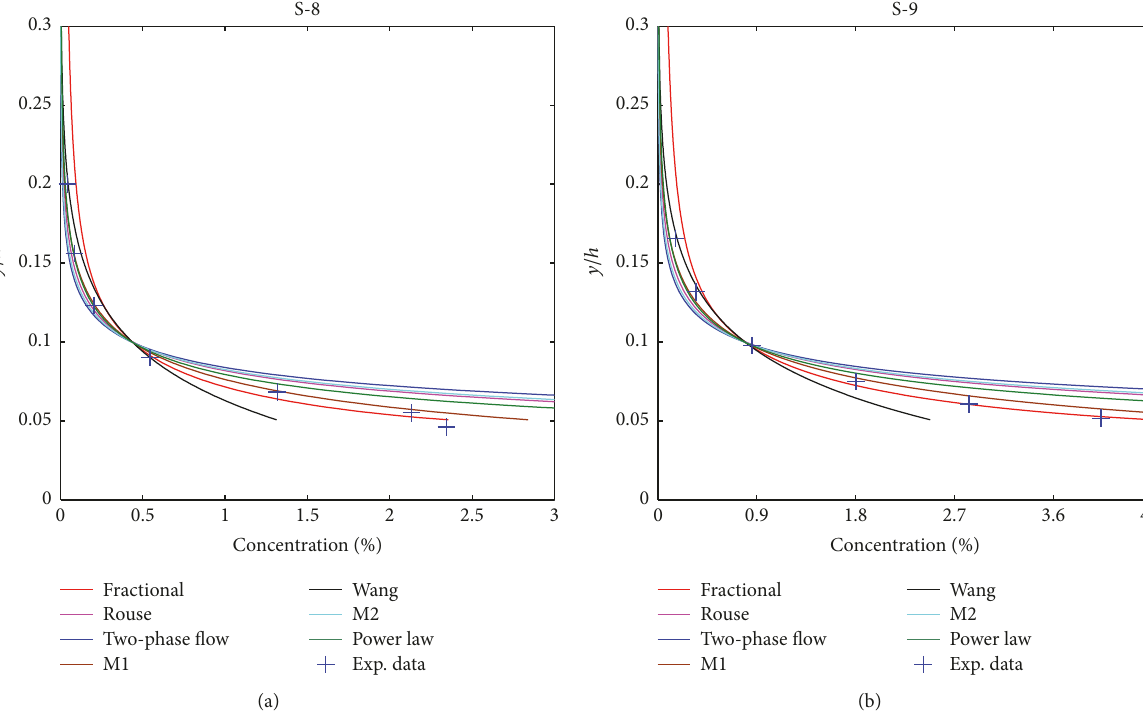
Figure 5: Results of the different models in describing the experimental data of Einstein and Chien [27]. (a) S-8 ( d = 0.94 mm), the fractional derivative order 𝛼 = 0.88 , and the reference height a = 0.1 h . (b) S-9 ( d = 0.94 mm), the fractional derivative order 𝛼 = 0.88 , and the reference height a = 0.1 h